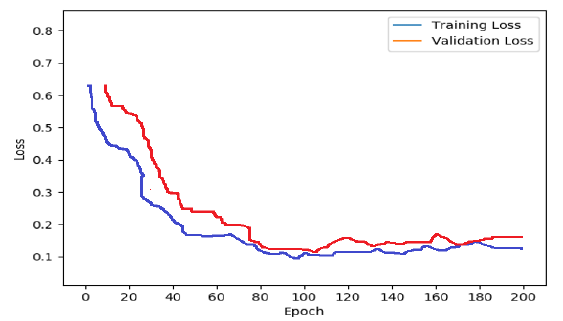
Figure 12. Training and Validation loss